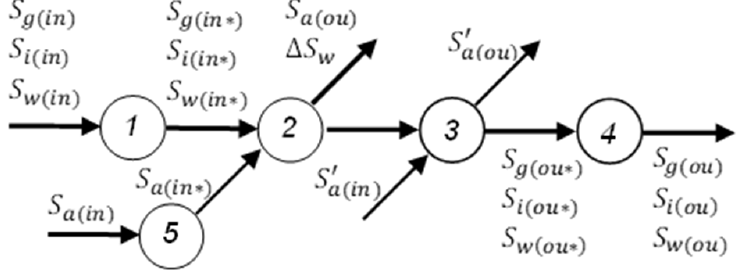
Figure 3. Decomposition of the grain dryer into functional units. 1. Loading unit; 2. drying chamber;